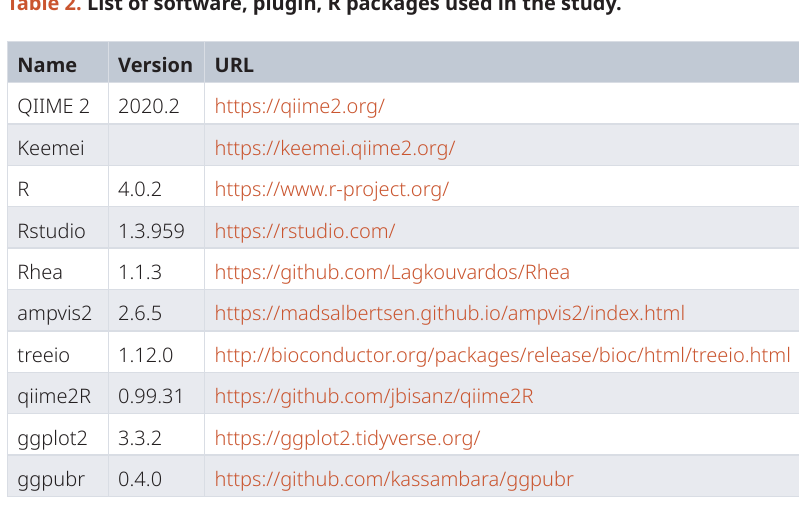
Table 2. List of software, plugin, R packages used in the